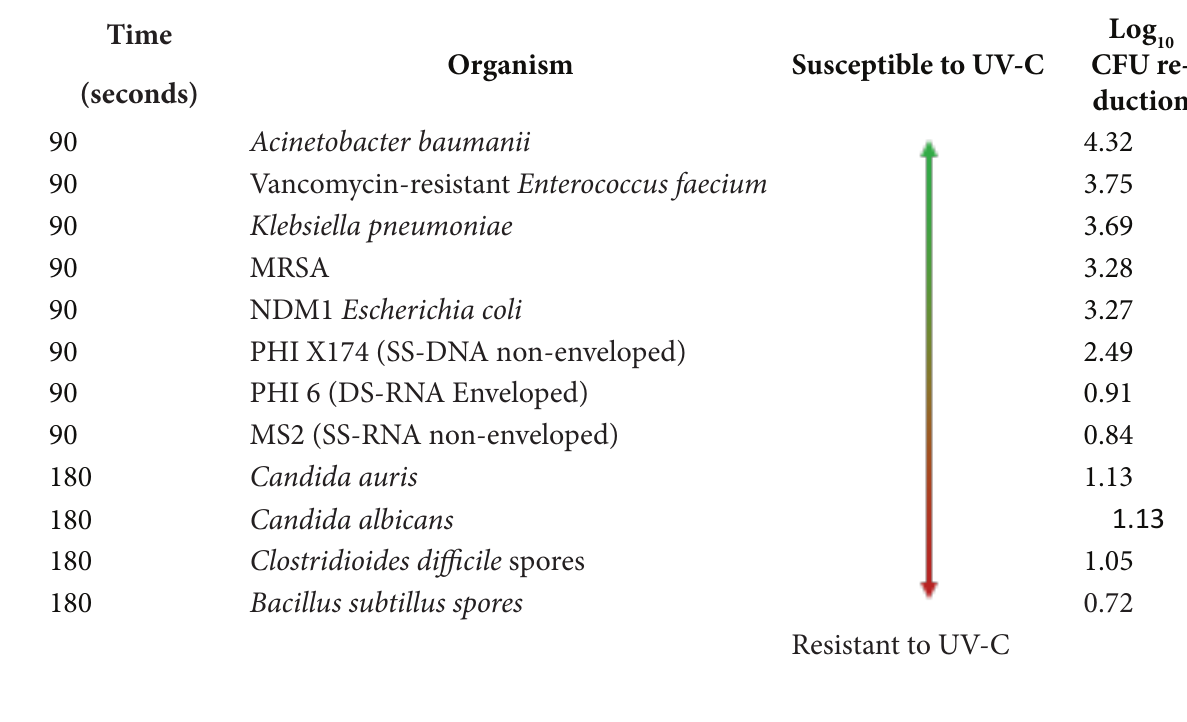
Table 2. Comparison of log10 colony-forming unit (CFU) or plaque-forming unit (PFU) reduc- tions achieved on steel disk carriers by 90 seconds or 180 seconds of exposure to UV-C from a room decontamination